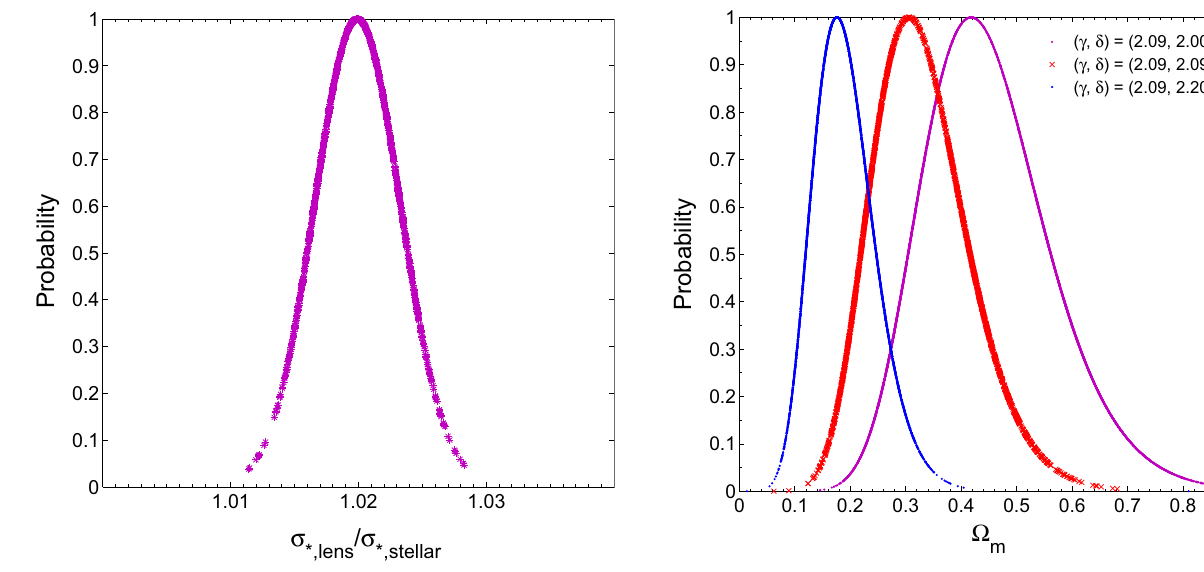
Fig. 8 Confidence limits on the ratio of the SIE velocity dispersion to the stellar velocity dispersion, which are derived from the simulated LSST strong lensing data